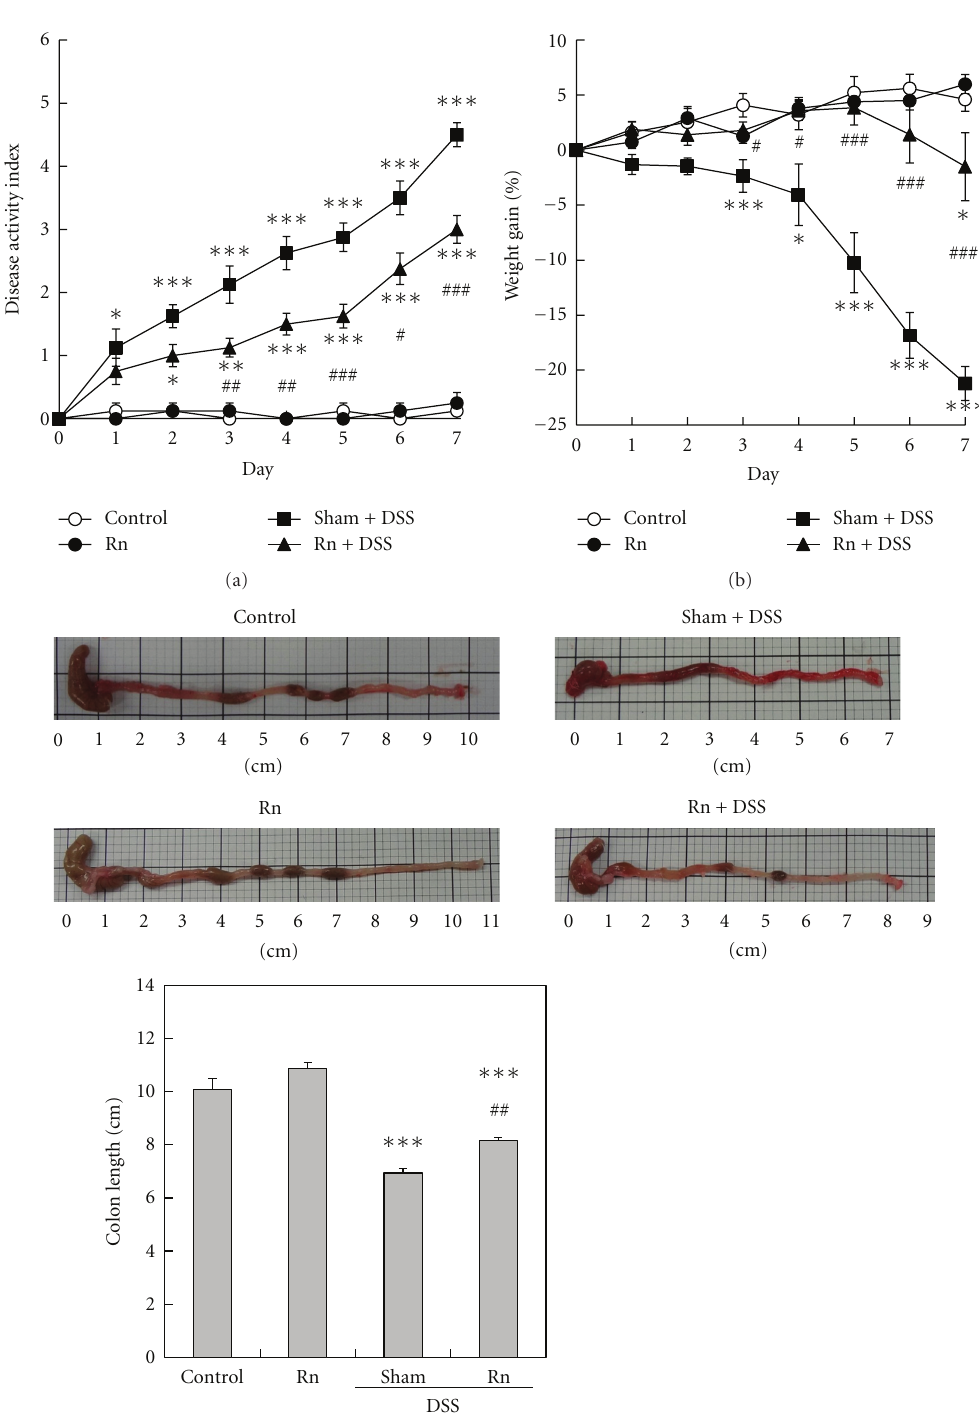
Figure 1: General observation of colitis. (a) Disease activity index score, (b) weight change, and (c) colon length. Each value is the mean ± SEM. The number of mice per experimental point was 8. ∗ P < 0 . 05, ∗∗ P < 0 . 01, and ∗∗∗ P < 0 . 001 versus control. # P < 0 . 05, ## P < 0 . 01, and ### P < 0 . 001 versus sham inhalation with DSS